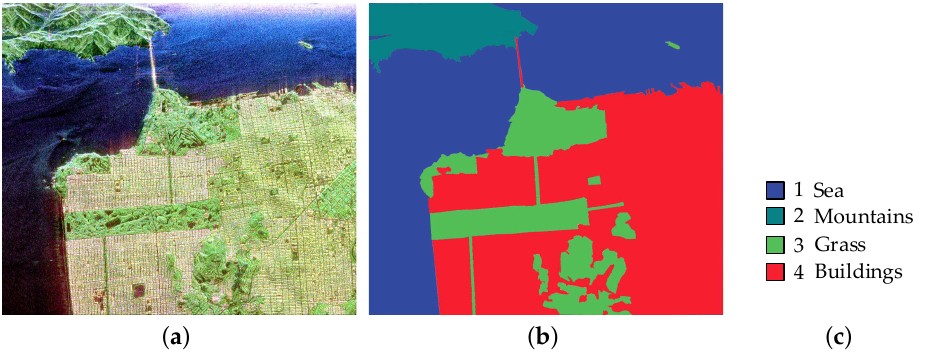
Figure 5. ( a ) The Pauli color-code image of San Francisco data set. ( b ) The corresponding ground truth. ( c ) The legend of the ground